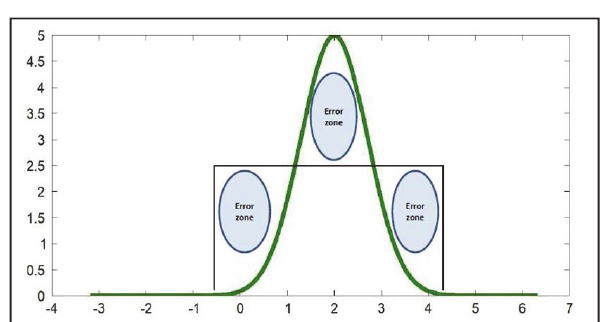
Fig. 17. Sketch of the error that occurs when constant velocity during a stream of particles happens, compared to a more real velocity distribution in function of time (Gaussian). In x axis time and in y axis erosion. Values are not significative, it is a conceptual-graphical example. This graphical demonstration is related to cumulative